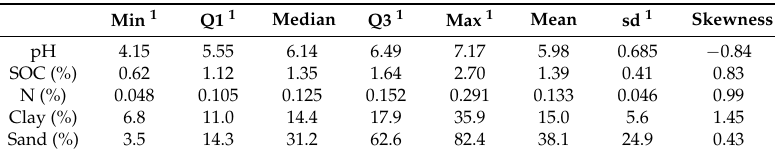
Table 1. Summary of chemical data for the studied soil samples ( n =